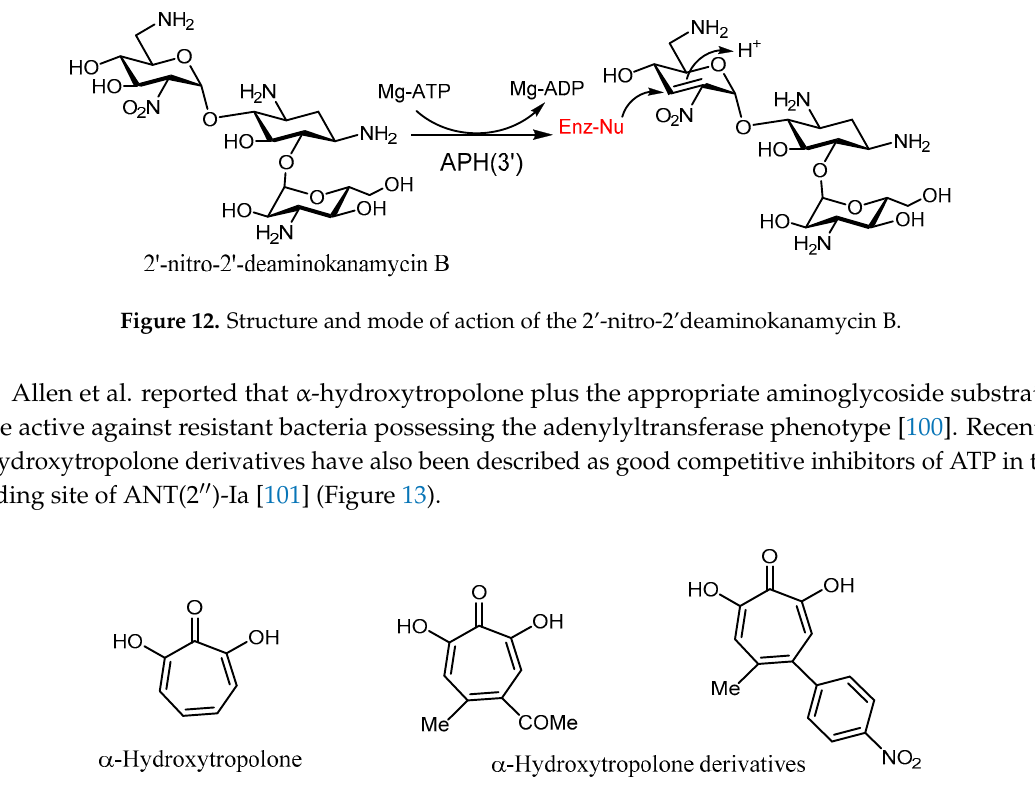
Figure 13. Structure of hydroxytropolone derivatives.